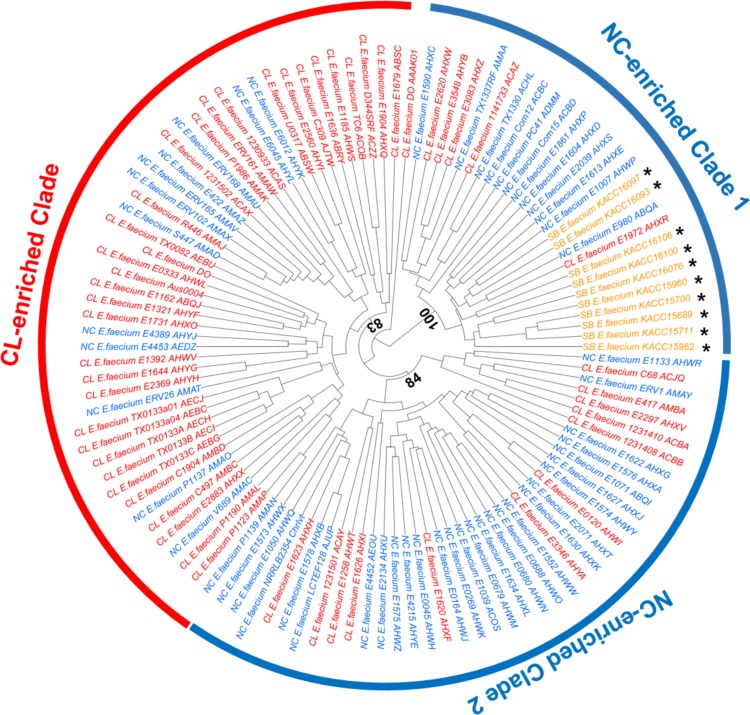
Hierarchical clustering of the 113 E. faecium strains used in this study.Based on ortholog presence/absence, clusters were obtained. Asterisks indicate the 10 soybean strains (Prefix: SB). Clinical and non-clinical strains were indicated by different prefixes, CL and NC, respectively. Approximately unbiased probabilities for the bootstrapping are shown in the center of the dendrogram.